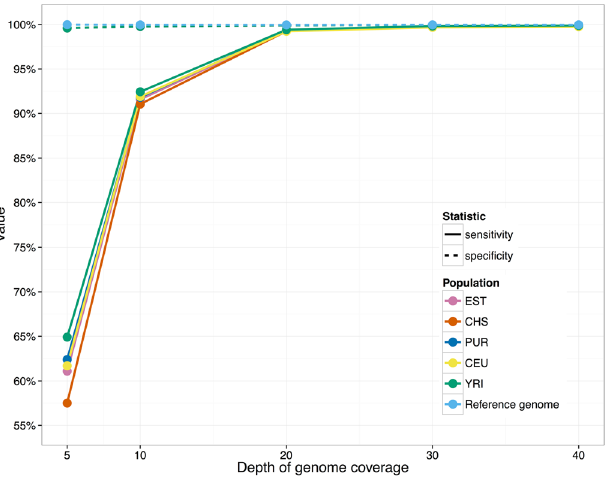
Figure 3. Performance of Bayesian classifier with simulated data. Sensitivity and specificity of calling alternative alleles is shown for reference genome and simulated genome of individuals from 5 different populations. Populations are abbreviated as follows: EST – Estonian; CHS – Southern Han Chinese; PUR – Puerto Rican; CEU – Utah residents with Northern and Western European Ancestry; YRI – Yoruban from Ibadan, Nigeria. Specificities are nearly identical for all individuals and thus their lines are overlapping with the green dotted line.